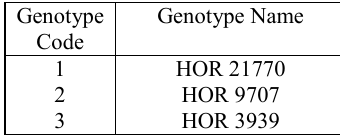
Table 1. Relevant lodge genotypes for study